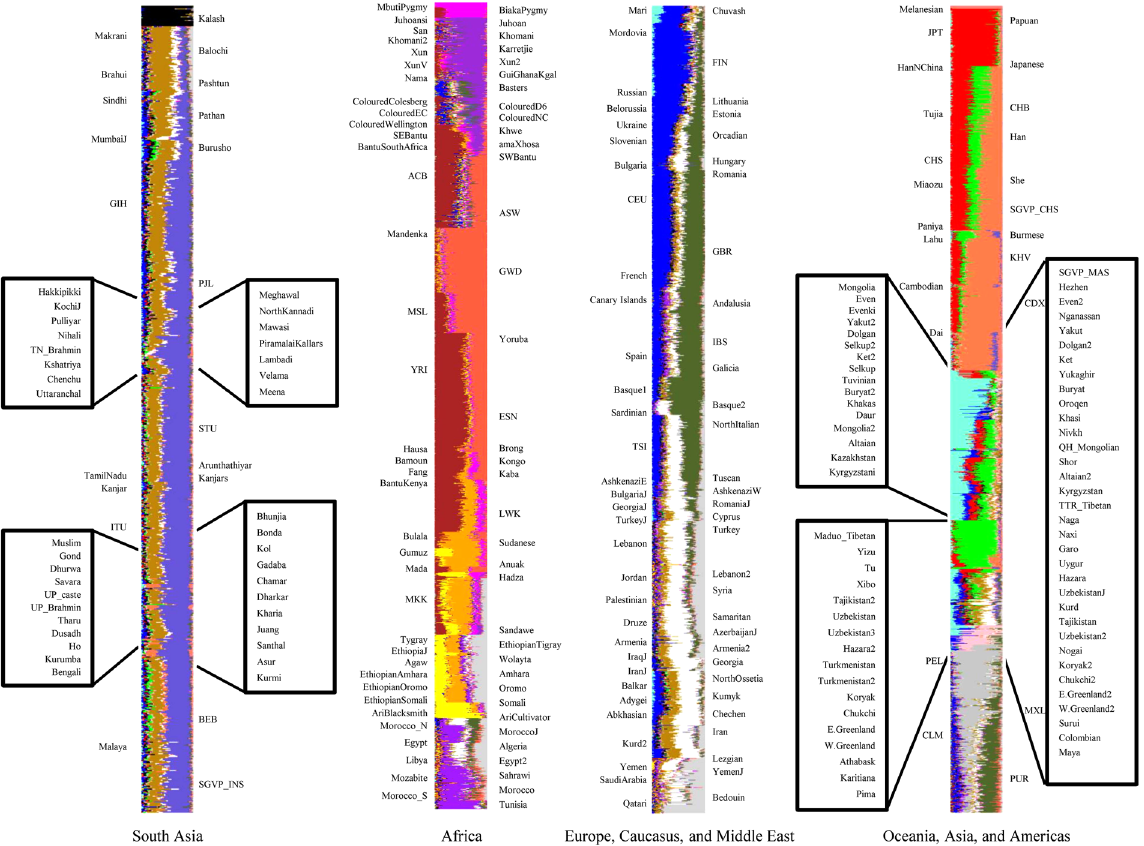
Figure 1. Ancestry analysis of the global data set. The 282 samples are labeled alternating in the left and right margins. The 21 ancestral components are Kalash (black), Southern Asian (dark goldenrod), South Indian (slate blue), Central African (magenta), Southern African (dark orchid), West-Central African (brown), Western African (tomato), Eastern African (orange), Omotic (yellow), Northern African (purple), Northern European (blue), Southern European (dark olive green), Western Asian (white), Arabian (light gray), Oceanian (salmon), Japanese (red), Southeastern Asian (coral), Northern Asian (aquamarine), Sino-Tibetan (green), Circumpolar (pink), and Amerindian